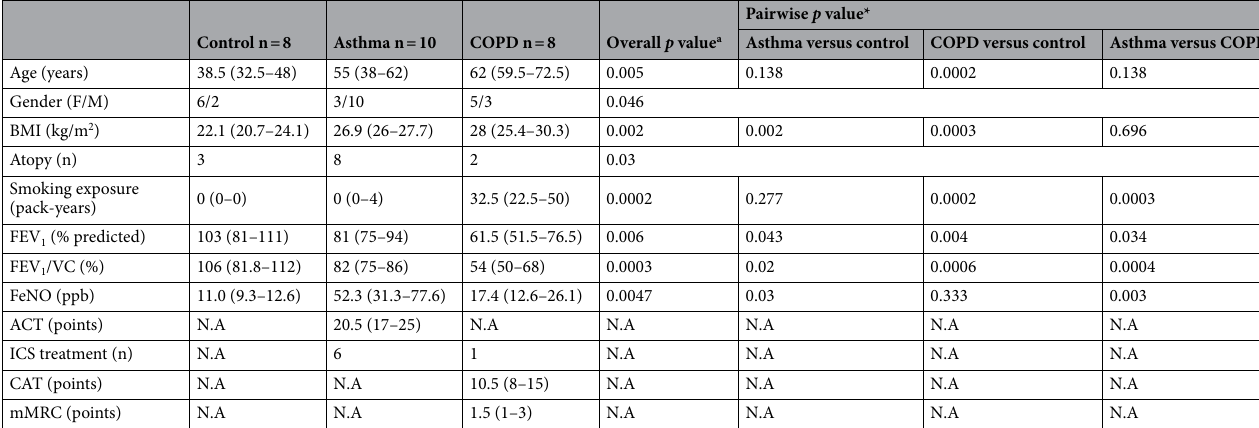
Table 1. The patients’ characteristics. Data are presented as median (IQR) or n. ACT Asthma control test, BMI body mass index, FeNO fractional exhaled nitric oxide FEV 1 forced expiratory volume at first second,